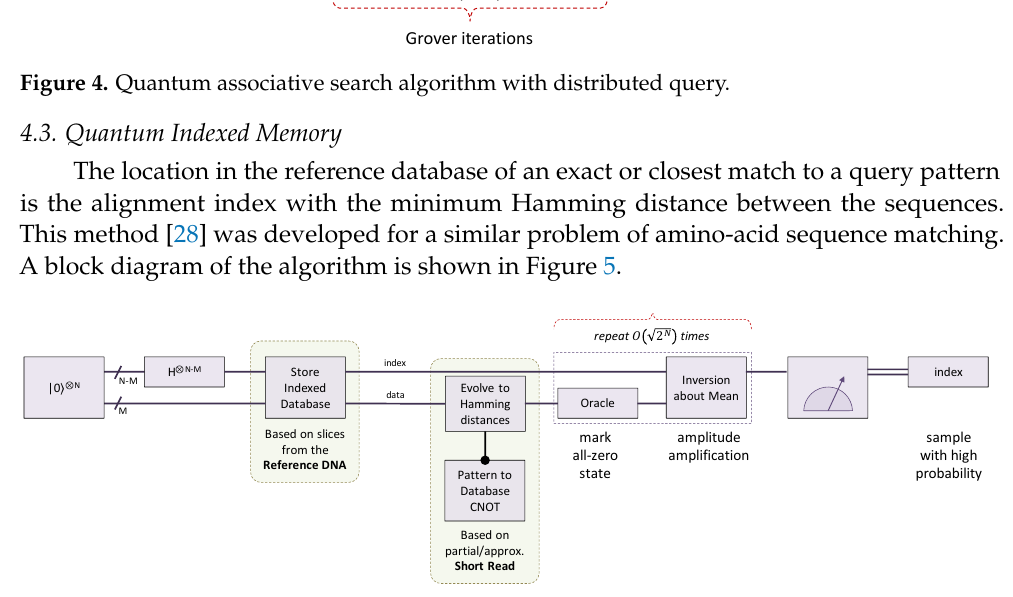
Figure 5. Quantum phone directory